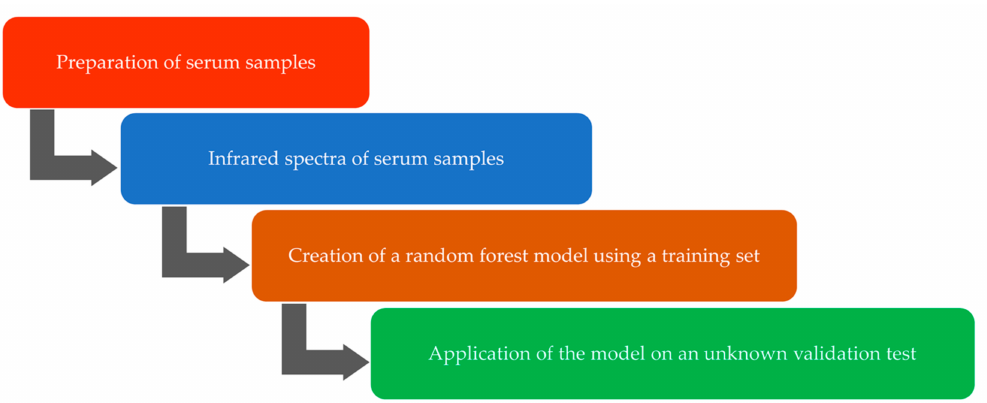
Figure 5. Workflow diagram showing the successive steps towards the distinction of the sera samples of the